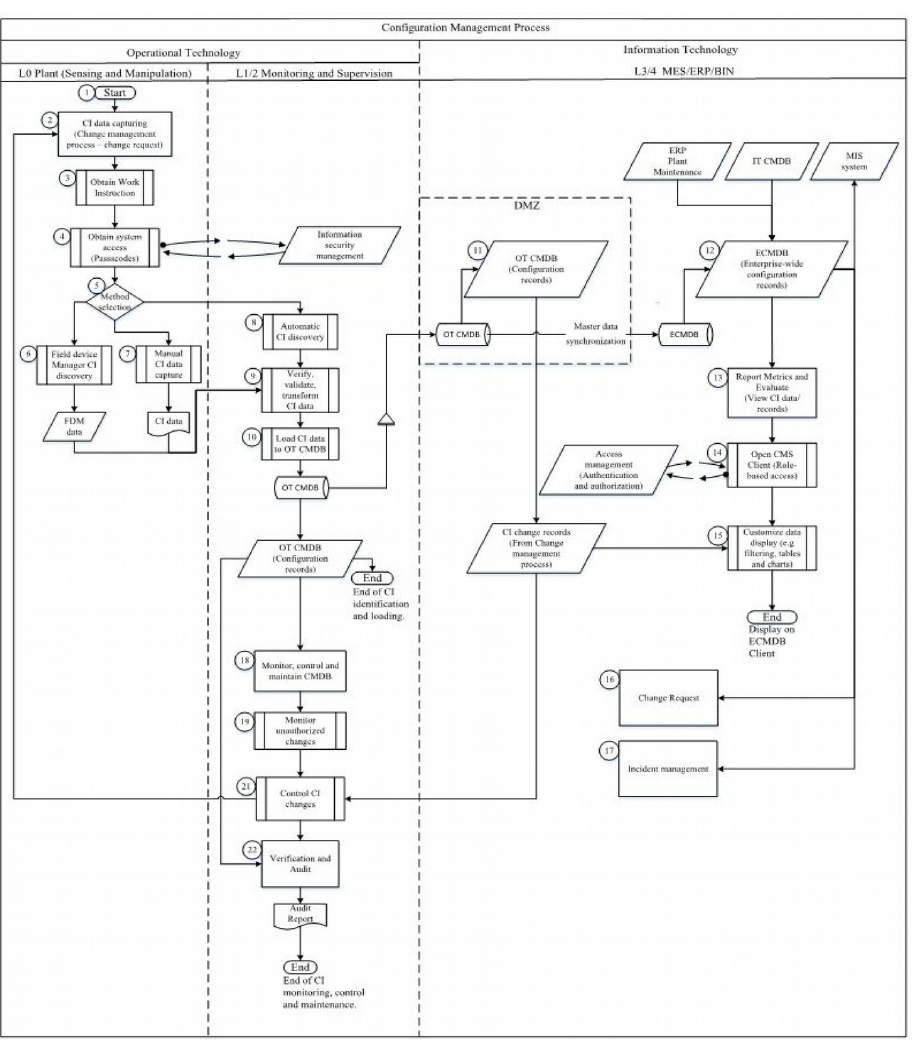
Figure 5. Sample OT configuration management